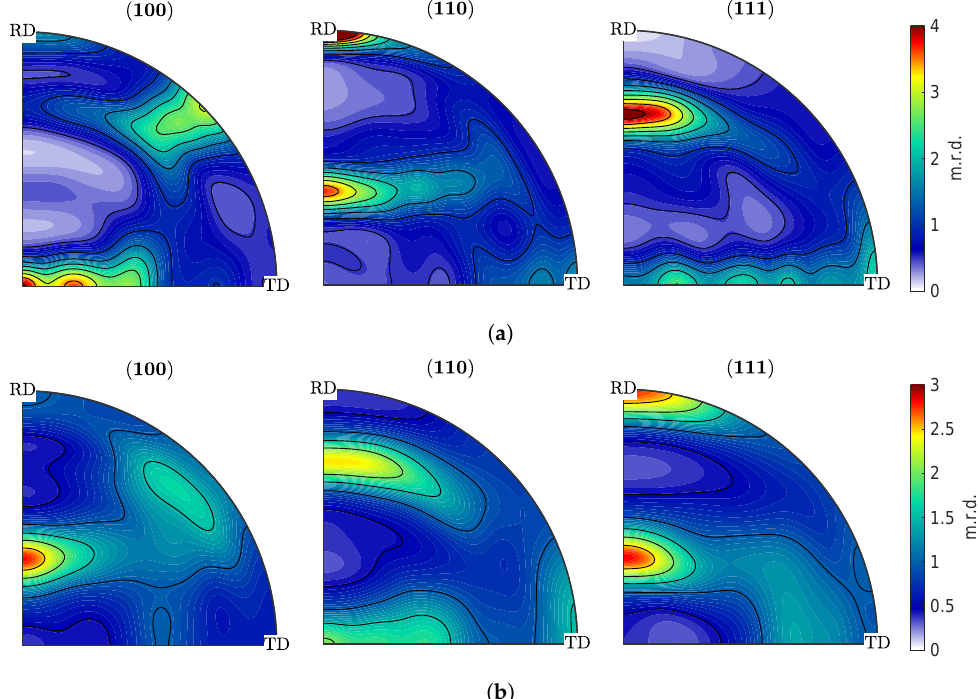
Figure 2. {100}-, {110}-, {111}-pole figures for ferrite and austenite recalculated from the orientation